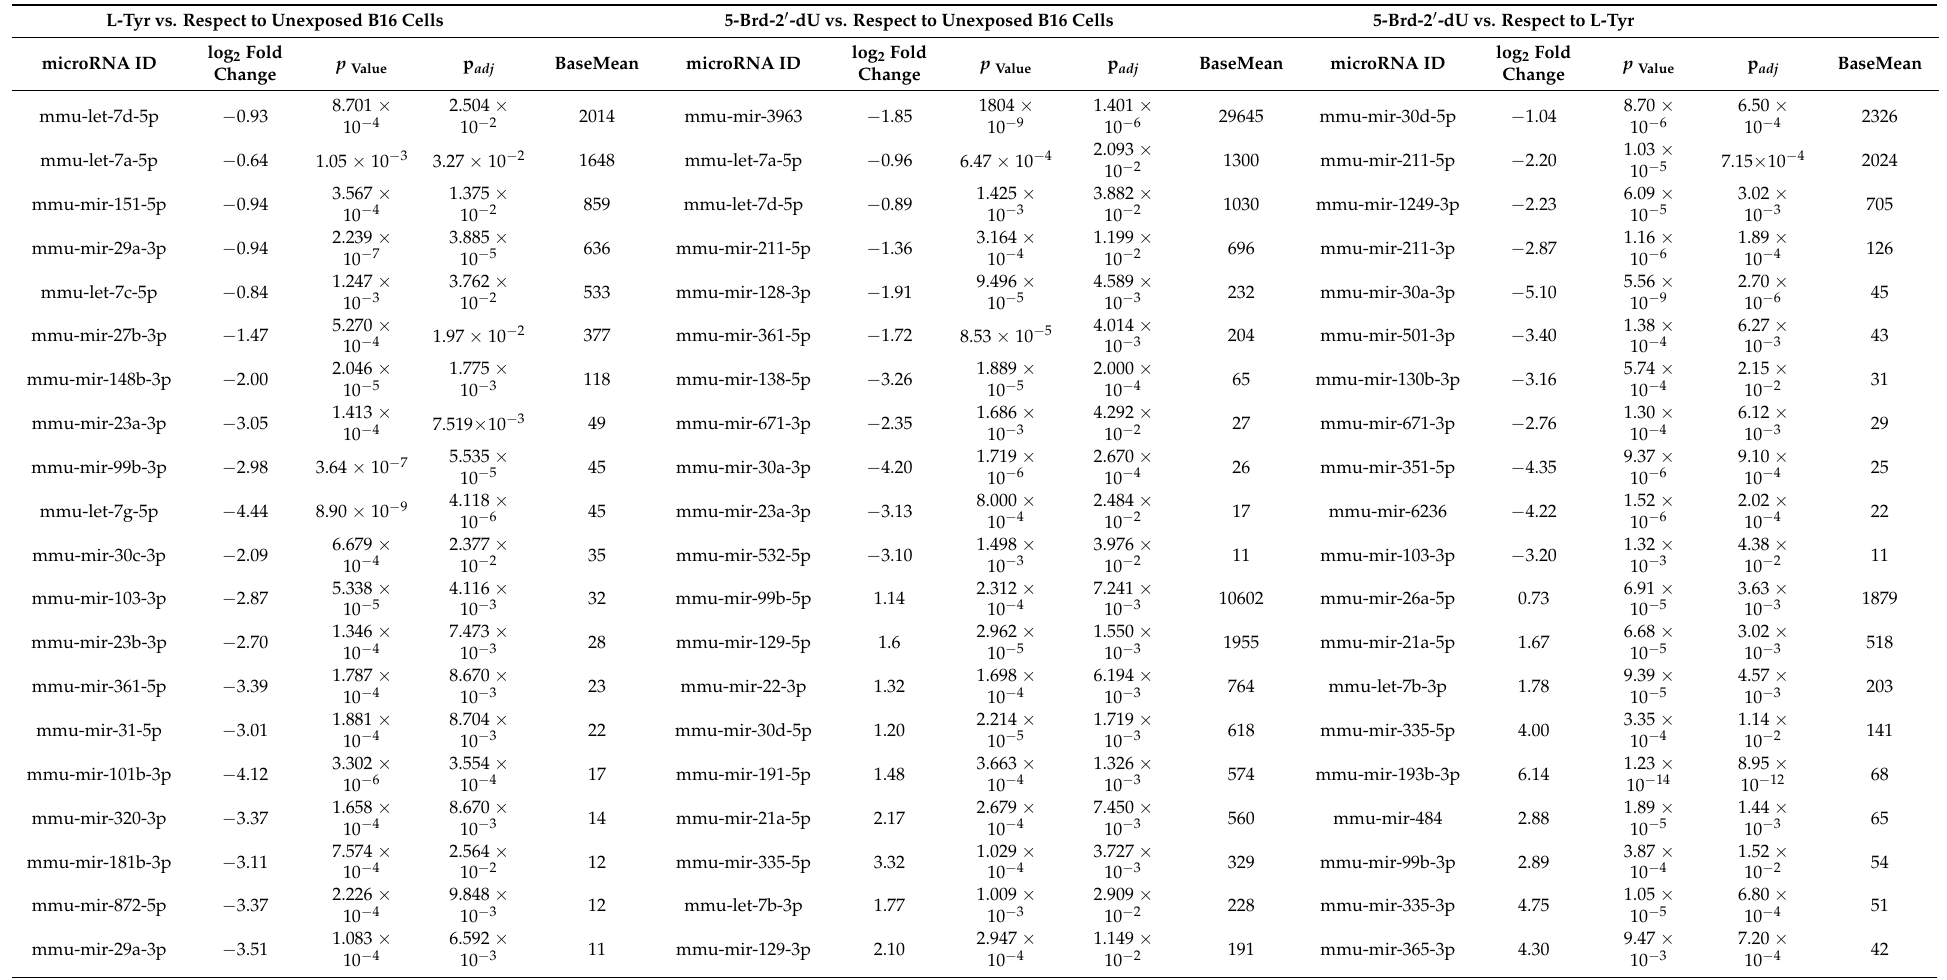
Table 1. List of differential microRNAs expression in B16F1 melanoma cells exposed for 72 h to 5-Bromo-2-Deoxyuridine 2.5 µ g.mL − 1 or L-Tyrosine amino acid 5 mM. microRNA ID refers to the identification number of miRNA register in miRBase; Log2 Fold Change represents times of change in the expression; p -value corresponds to the statistical significance and p- adj significance by multiple tests correction; baseMean means the average